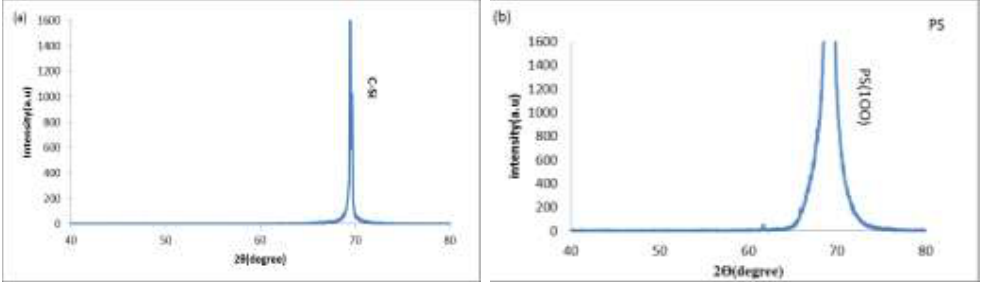
Figure 2: (a) bulk-Si, XRD pattern (b) porous Si was prepared at 20 mA/cm 2 , with a 15-minute etching time and a 20% HFC